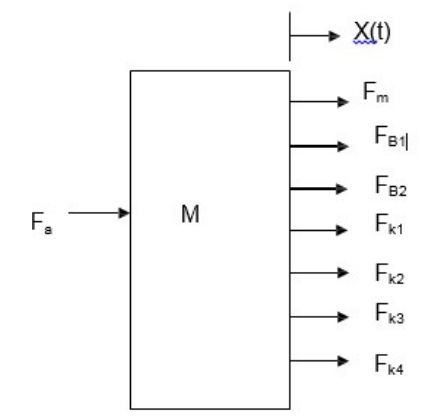
Figure 2: Dynamic model of the proposed design